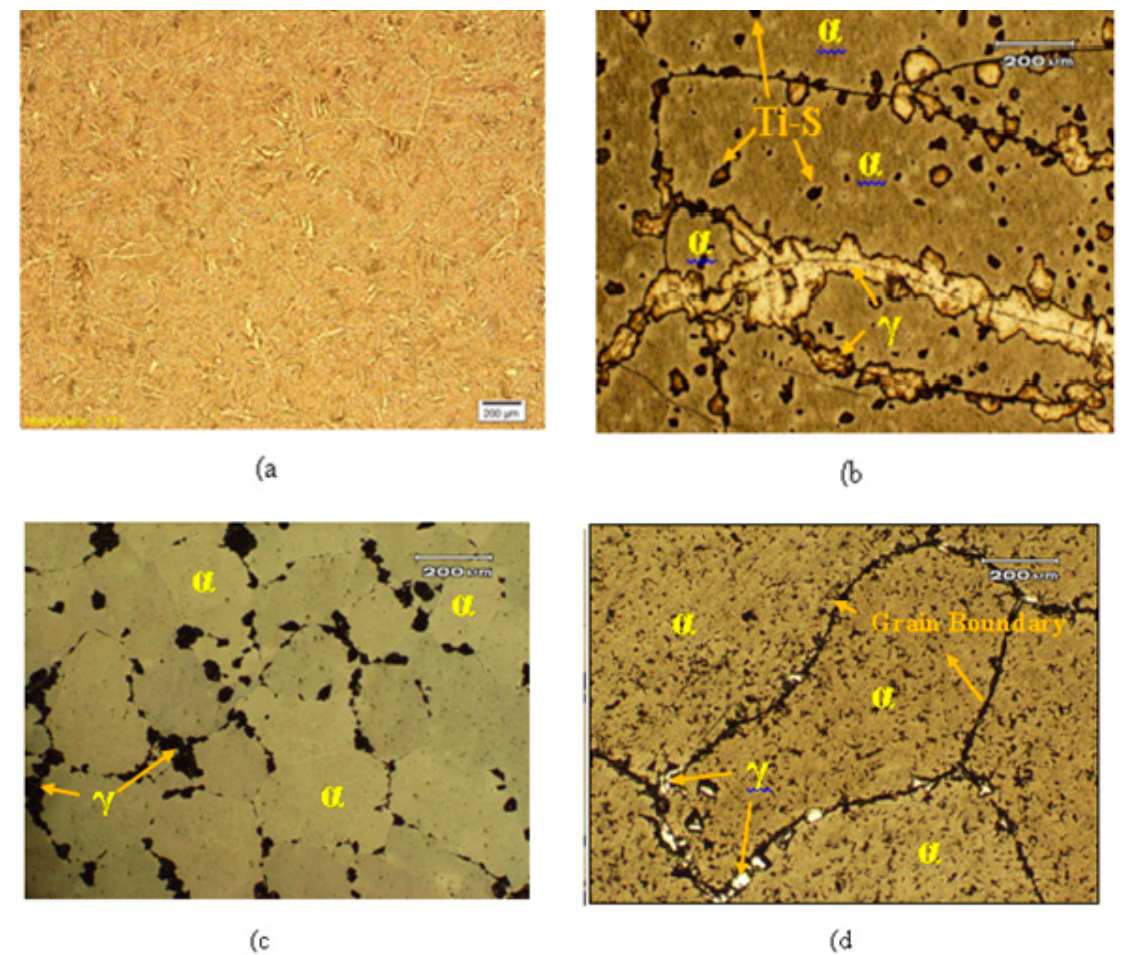
Figure 4. Optical micrograph consisting of single-phase alpha and gamma phases ( a ) the cast dendritic structure of ( b ) Sample A after complete heat treatment; ( c ) Sample B after complete heat treatment; and ( d ) Sample C after complete heat treatment.